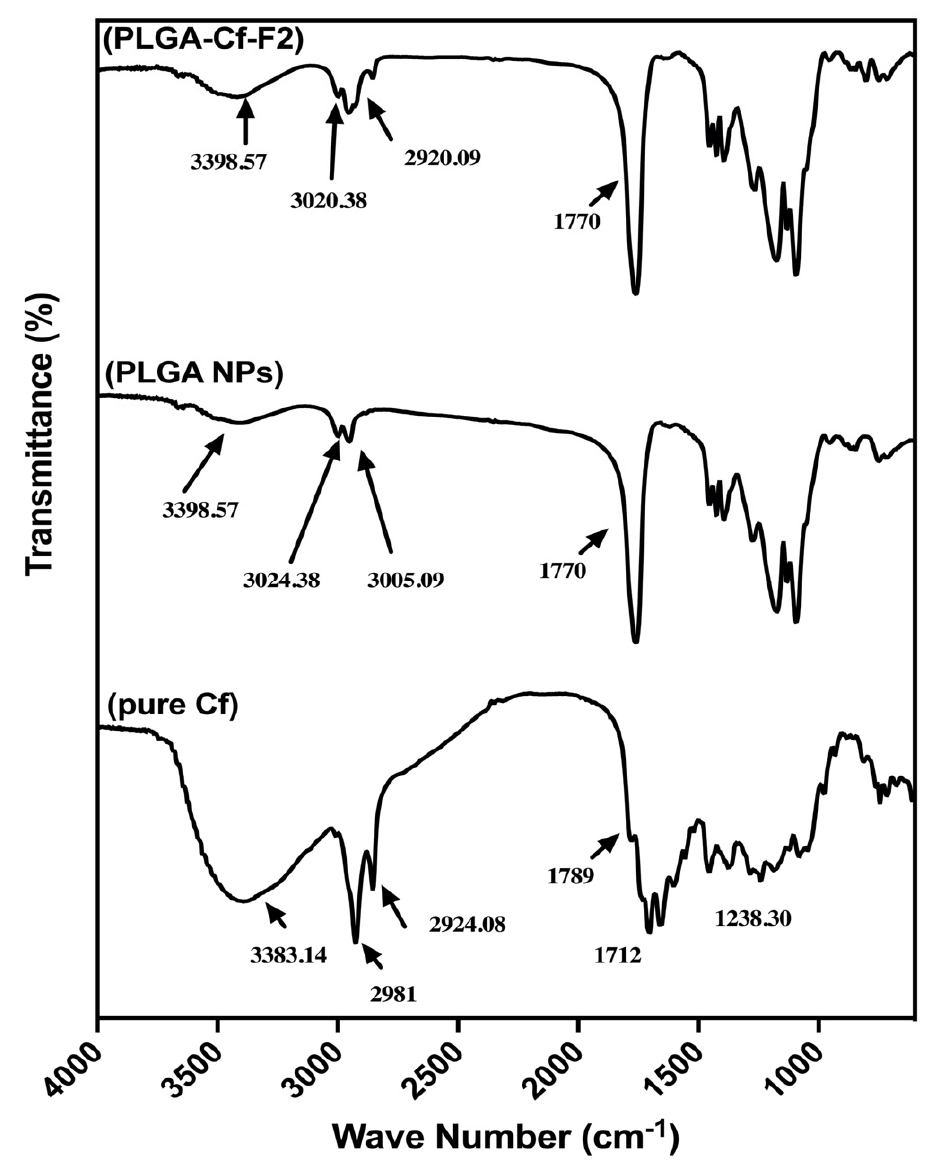
Figure 4. The FT-IR spectra of pure Cf, PLGA NPs, and PLGA-Cf-F 2 .